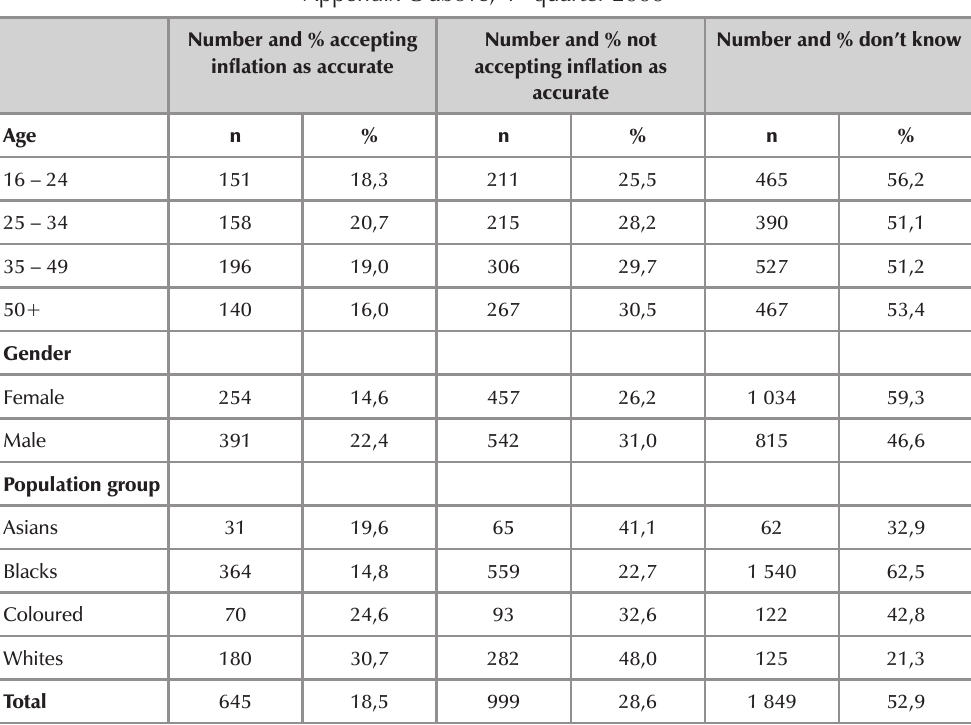
Responses about inflation credibility according to age, gender, population group and the